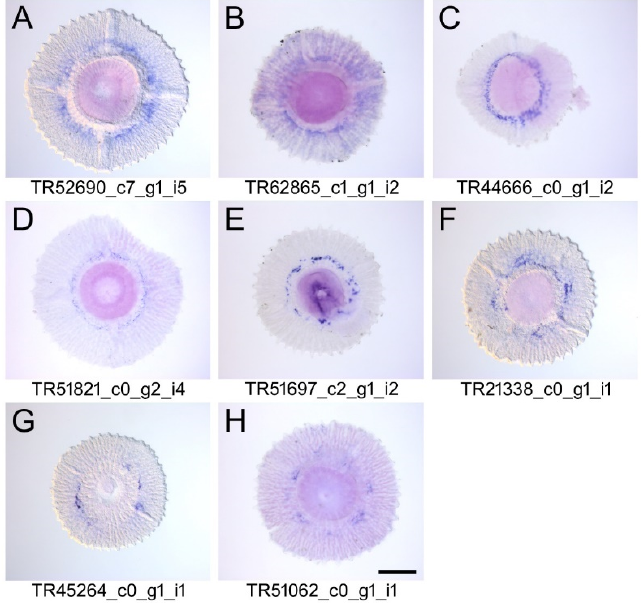
Figure A3. In situ hybridization screen panel 3. ( A – H ) Ventral view onto the tube foot disc. The distribution of the in situ hybridization signal (blue) is weak, but shows distinct expression in a subset of disc cells. Therefore, these transcripts represent proteins of unknown function. Scale bar, 200 µm.